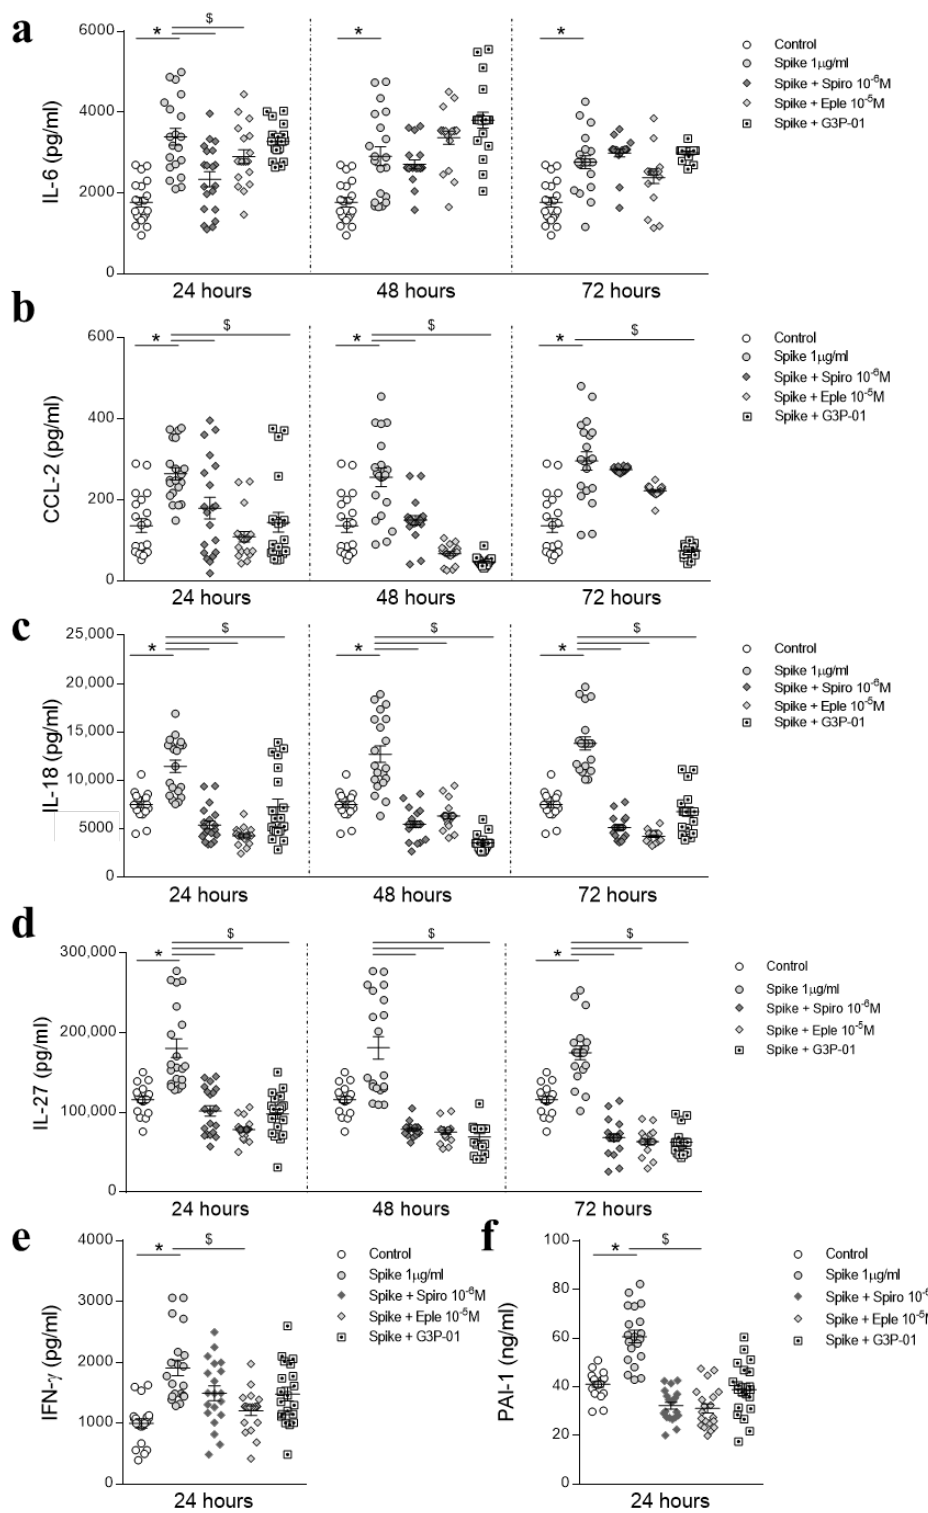
Figure 4. Preventive effects of MR pathway blockade on Spike protein proinflammatory effects in HAECs. The secretion of proinflammatory molecules was evaluated in HAECs pre-treated with Spironolactone, Eplerenone, or G3P-01 and then treated with Spike for 24, 48, or 72 h. IL-6 ( a ), CCL-2 ( b ), IL-18 ( c ), IL-27 ( d ), IFN- γ ( e ), PAI-1 ( f ). Results were analyzed using one-way-ANOVA followed by Dunnet’s post-hoc multiple comparisons tests. Control, n = 20; Spike, n = 20; Spike + Spiro, n = 20; Spike + Eple, n = 20; Spike + G3P-01, n = 20. * vs. control; $ vs. Spike.